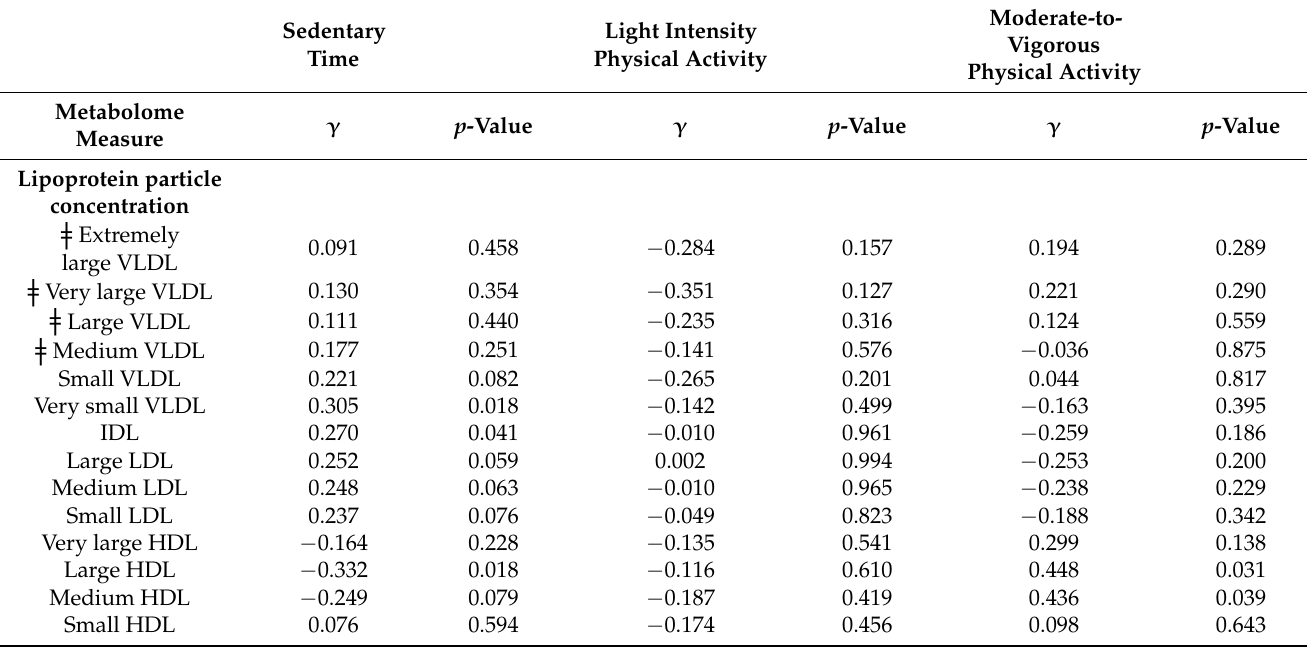
Table 3. Compositional analysis with standardized regression coefficients ( β ) of sedentary time and physical activity intensities for age, education, smoking, alcohol, nutrition-adjusted regression models for serum metabolome. Bonferroni-corrected p -value of ≤ 0.002 was set as the level for statistical significance, which corresponds to a p -value of less than